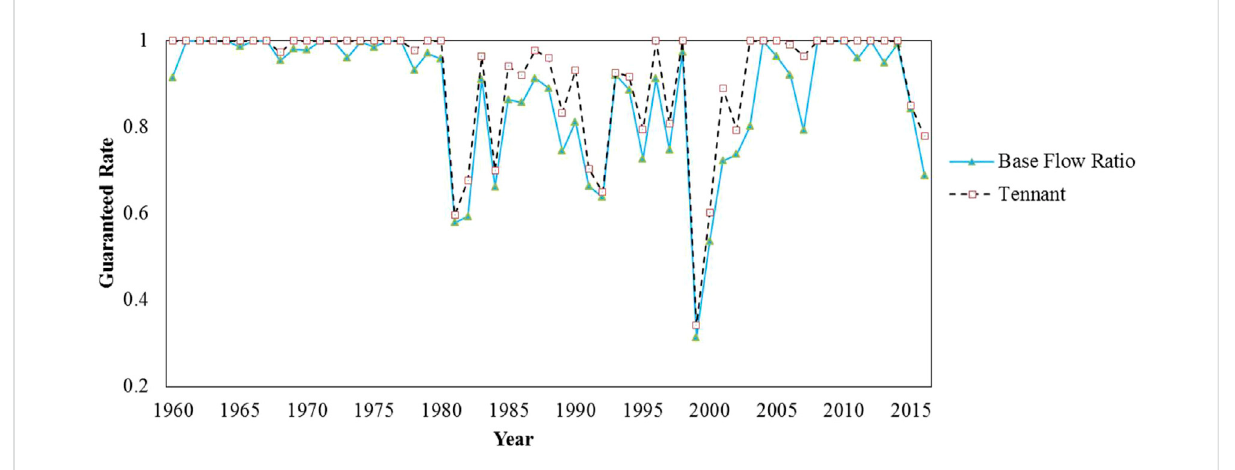
FIGURE 2 Guaranteed rate of ecological base fl ow over the study